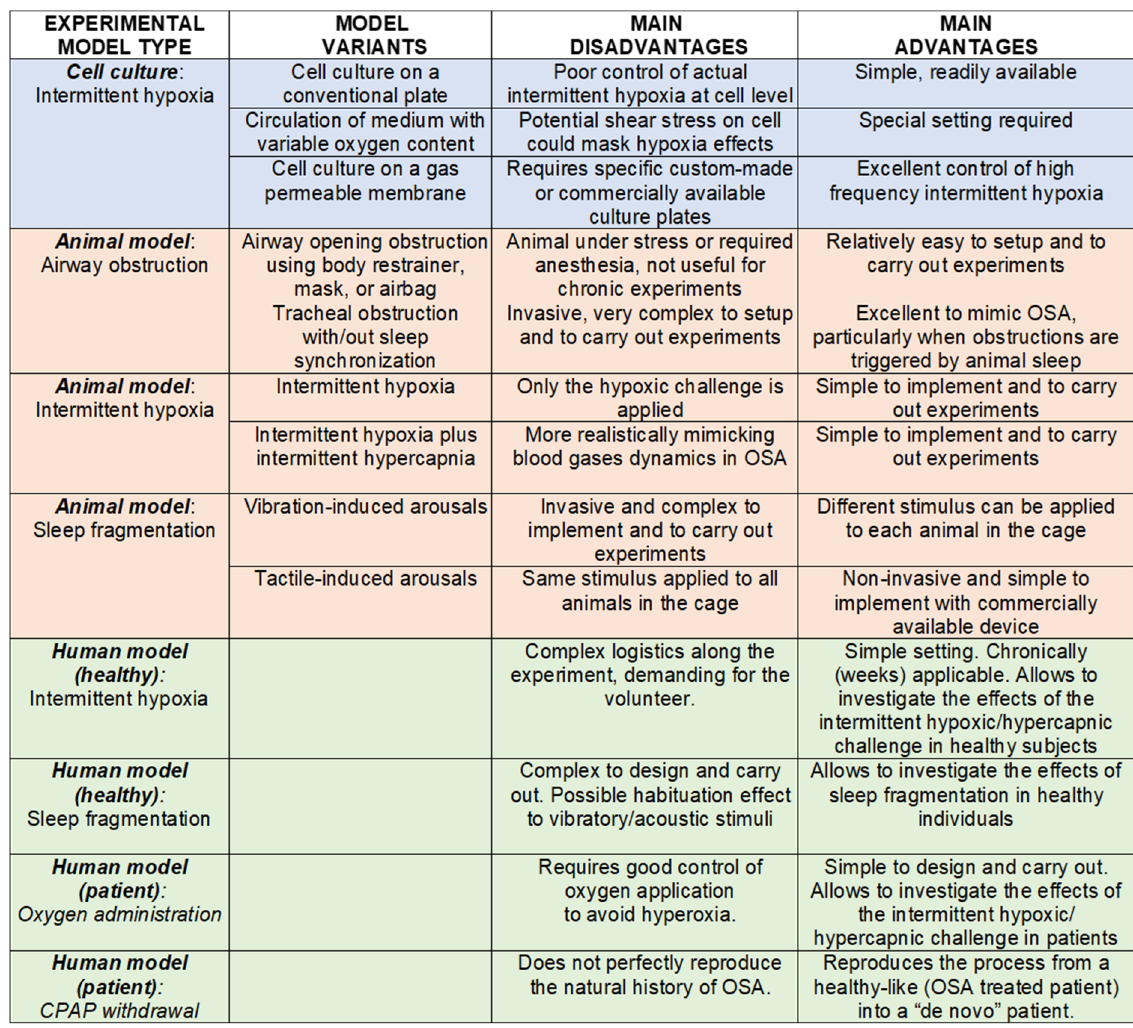
Figure 5. Experimental models to investigate the end-organ consequences of SA.